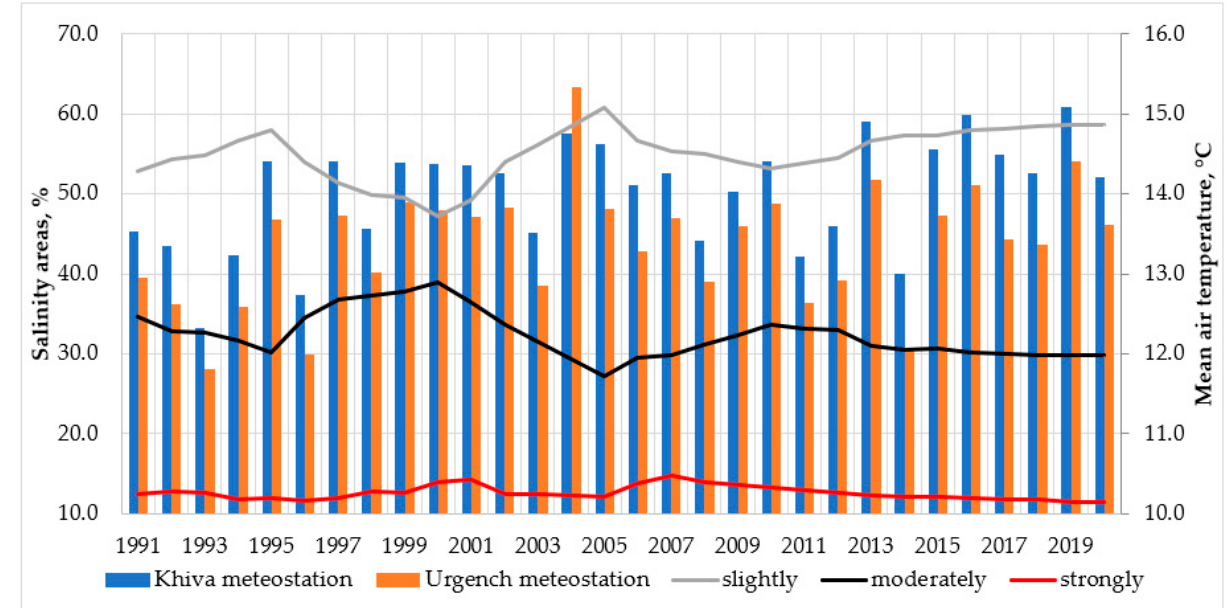
Figure 4. Dynamics of soil salinity and average air temperature change from 1991 to 2020.